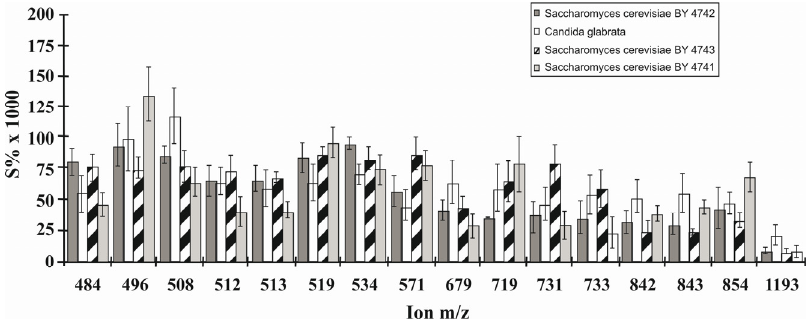
Figure 2. Relative abundances of characteristic ions (450–1200 Da) used to separate four different yeasts: S. cerevisiae (haploid strain BY2742), C. galbrata , S. cerevisiae (diploid strain BY4743), and S. cerevisiae (haploid strain BY4741). The x ‐ axes shows the selected ions; the y ‐ axes shows the relative ion abundance (calculation: S% × 1000). Figure reprinted with permission from [48]. Copyright 2005, American Chemical Society.